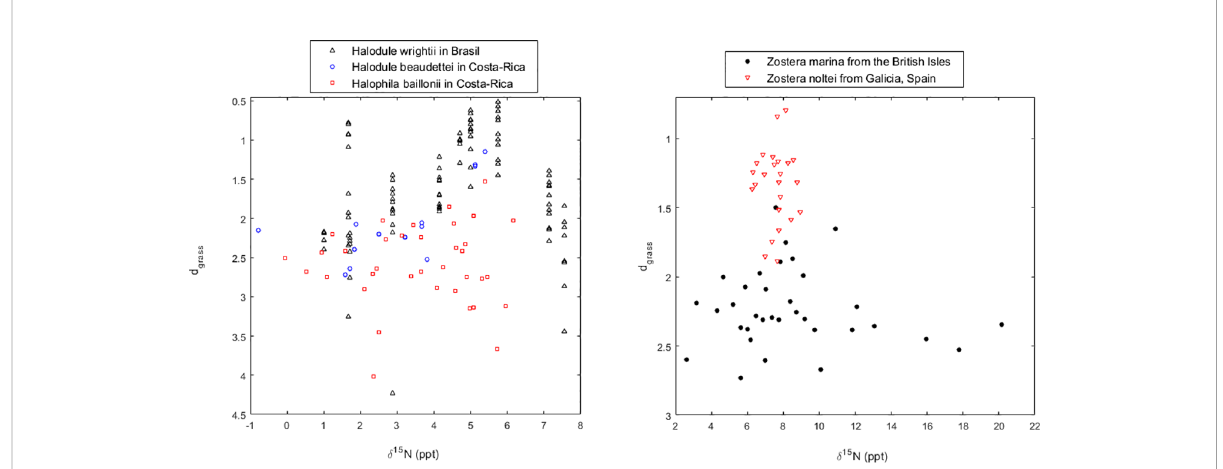
FIGURE 7 Health of seagrasses worldwide and their relation with the proportion of the d 15 N isotope to total N in seagrass leaf content. Seagrass health is indicated by their distance (d grass ) to the seagrass IBL (i.e., their ef fi ciency of space